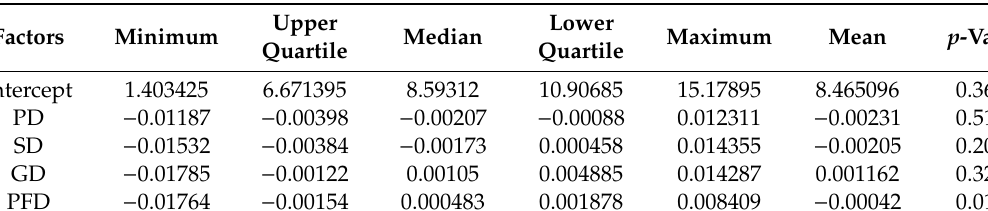
Table 3. The statists of regression coe ffi cient and p value in geographically weighted regression (GWR) model.